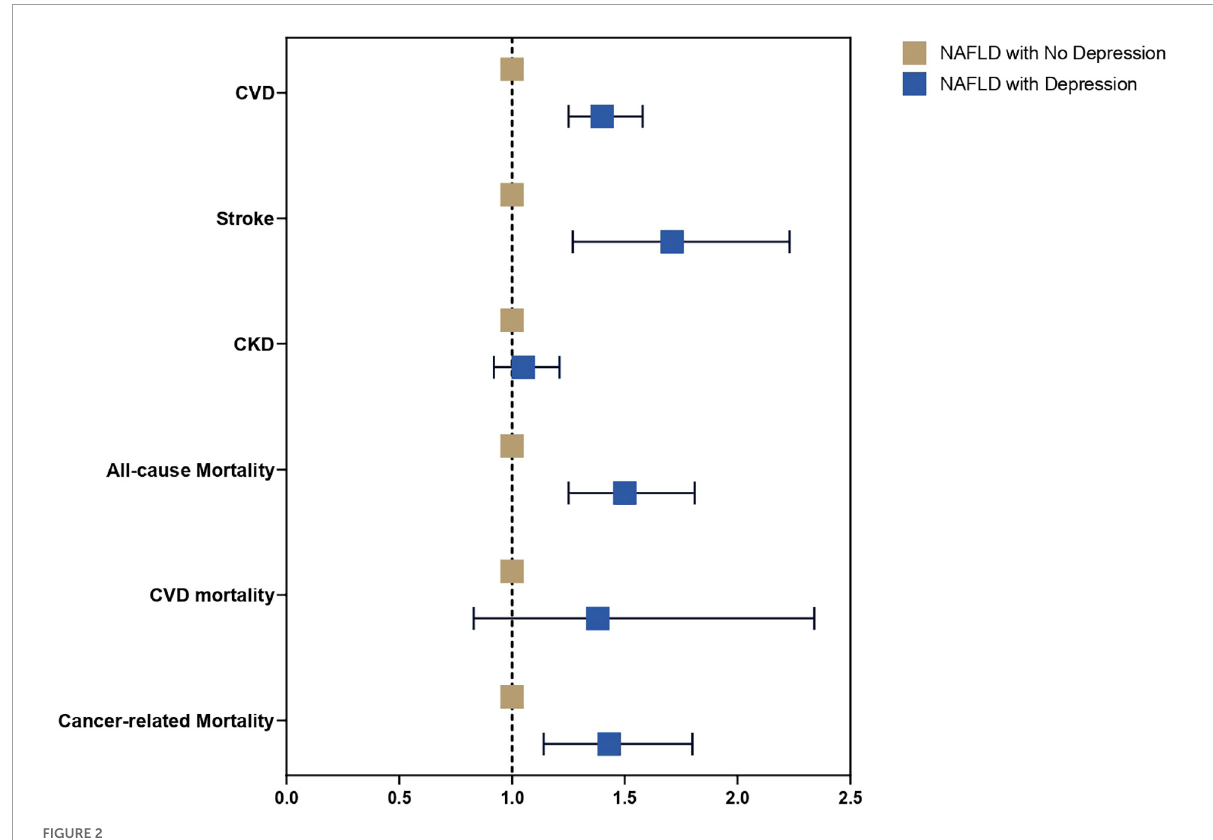
FIGURE2 Forest plots of adverse outcomes in NAFLD with and without depression.